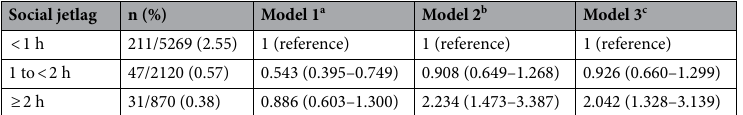
Table 2. Risk of chronic kidney disease according to the categories of social jetlag. a Crude odds ratio was calculated by logistic regression. b Adjusted odds ratio was calculated by multiple logistic regression analysis after adjusting for age and sex. c Adjusted odds ratio was calculated by multiple logistic regression analysis after adjusting for age, sex, marital status, occupation, weekly working hours, smoking, drinking, hypertension, diabetes, obesity, and self-rated